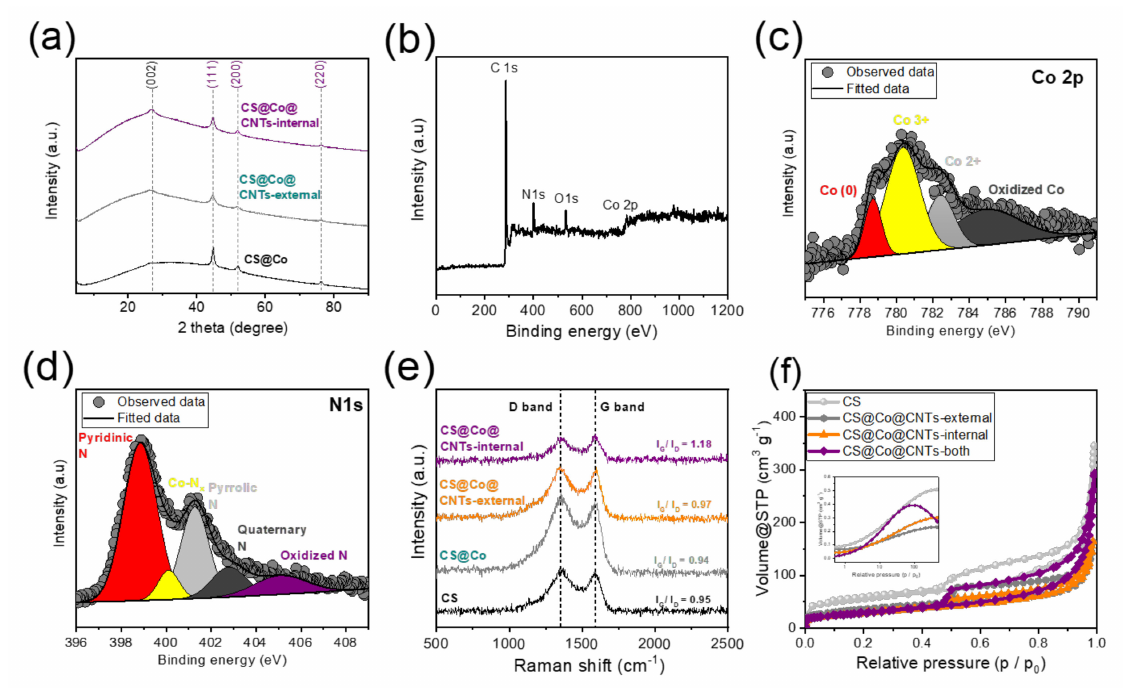
Figure 4. ( a ) XRD patterns of as-prepared carbon sponge electrodes, ( b ) XPS survey spectrum, fine ( c ) Co2p, ( d ) N1s spectrums of CS@Co@CNTs-internal. ( e ) Raman spectrum, ( f ) N 2 adsorption- desorption isotherm curves of carbon sponge electrodes (inset image in Figure 4f represents the pore size